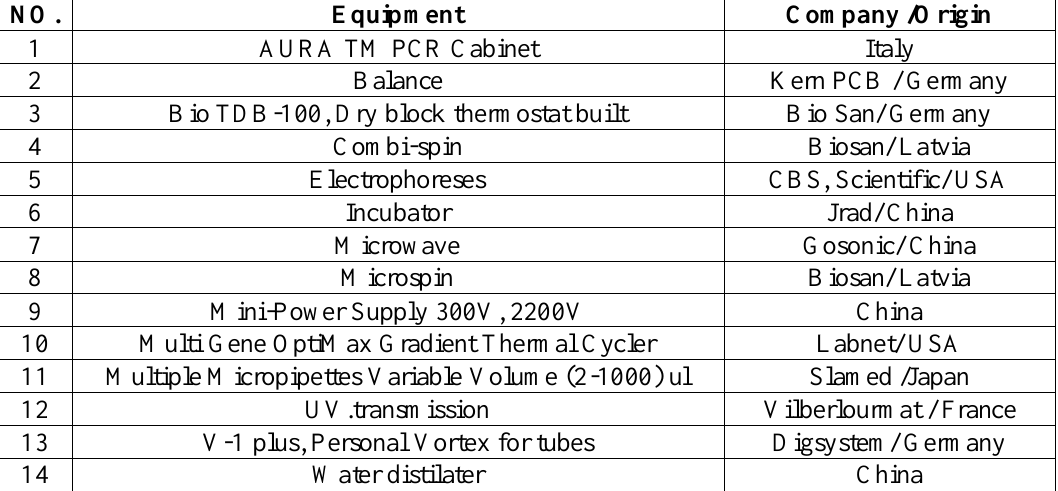
Table 1: The instruments and equipment used in this study.